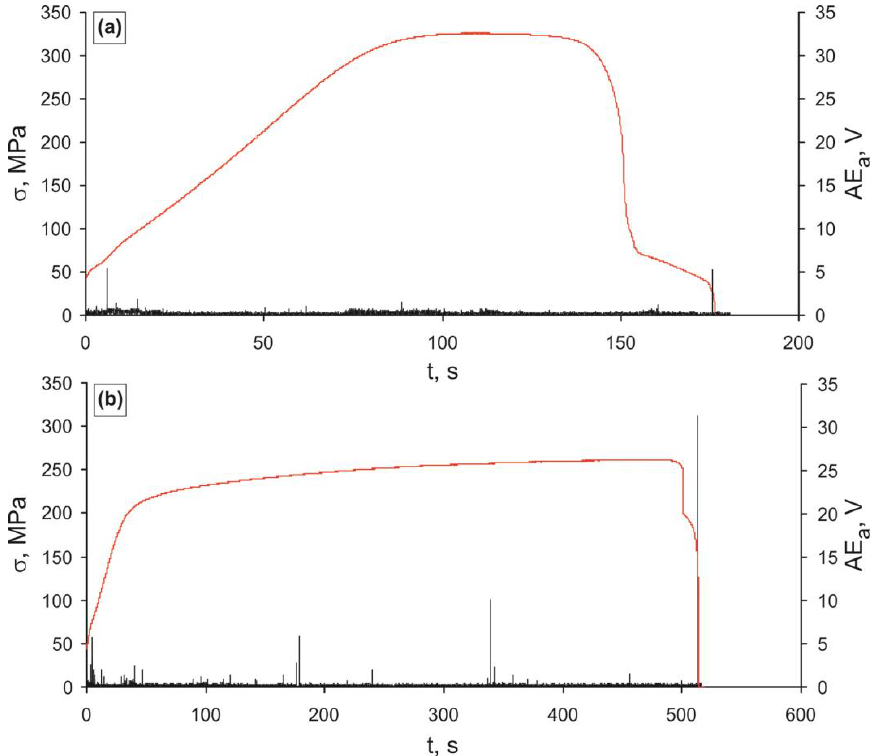
Figure 16. Combined AE diagrams and stress – strain curves for the 2.5-mm diameter composite sample ( e = 4.16) after annealing at ( а ) 180 °С and ( b ) 300 °С .